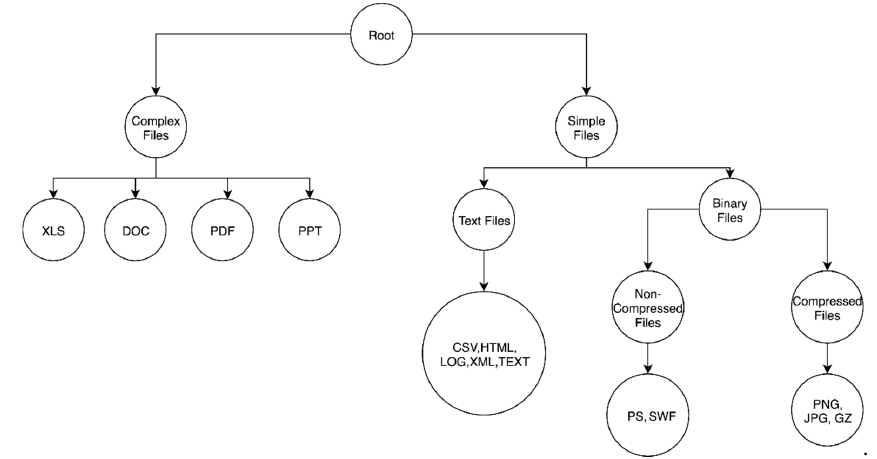
Figure 1. Hierarchy illustration for the files.